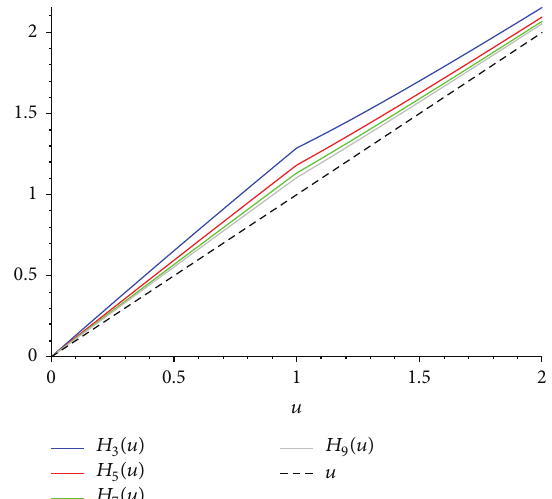
Figure 2: Example of kernels 𝐻 𝑤 (𝑢) , 𝑤 = 3, 5, 7,9